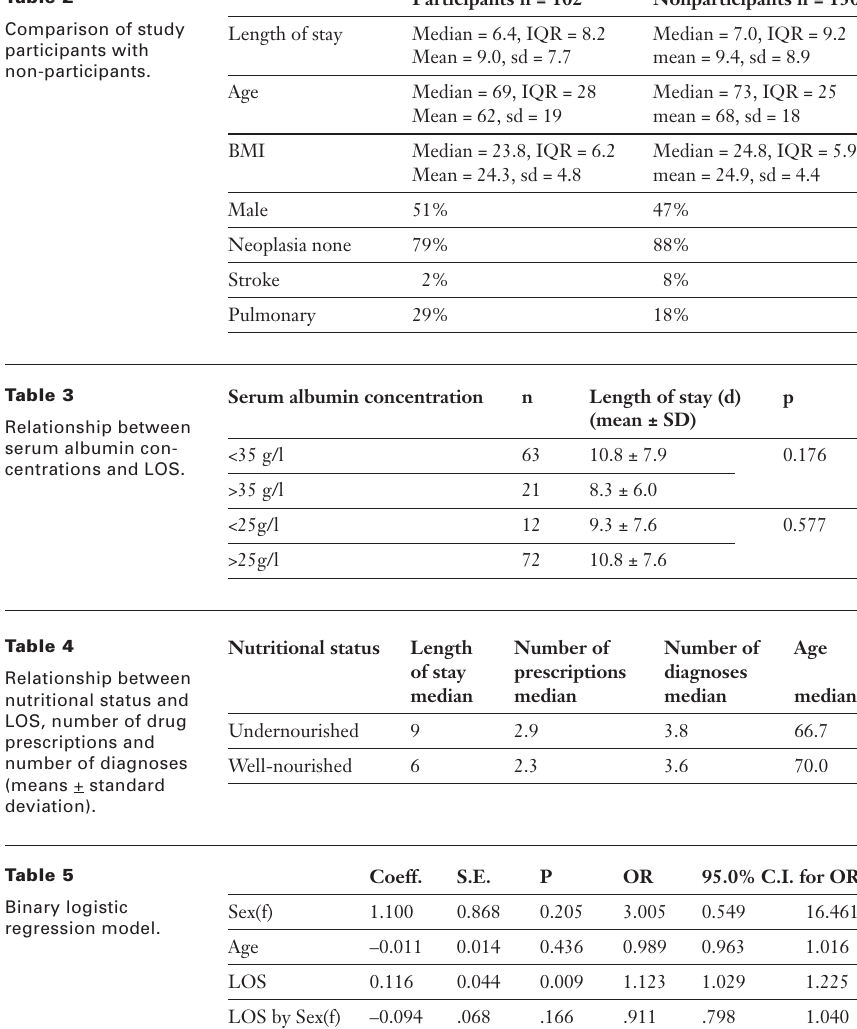
Comparison of study participants with non-participants.